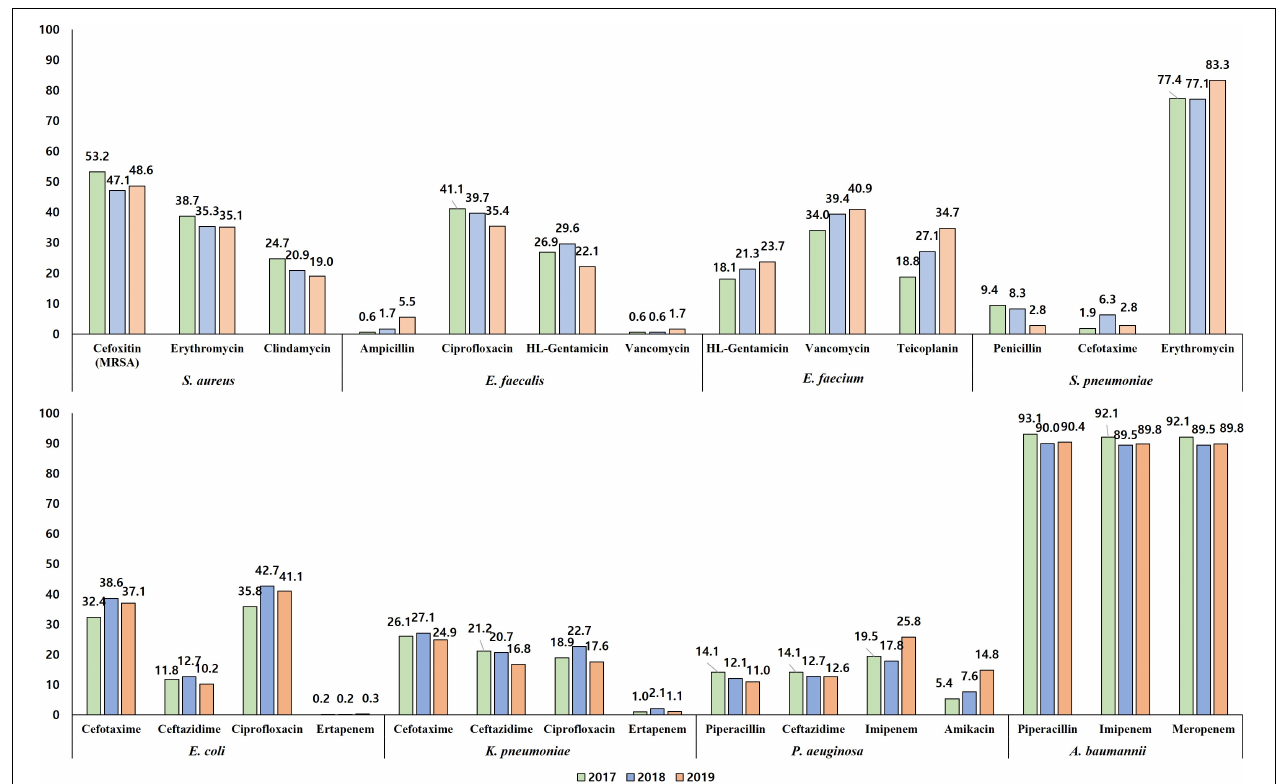
FIGURE 6 | The percentage of resistance to major antimicrobials of bloodstream infection-causing pathogens by year. The resistance rates determined by disk diffusion method are presented.